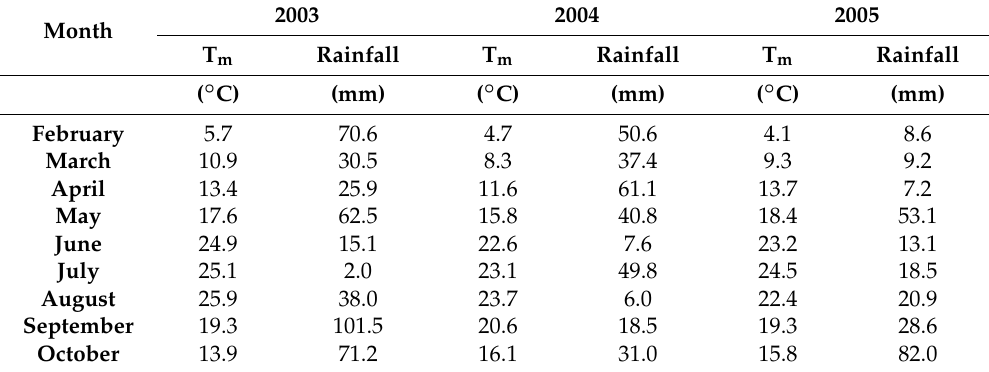
Table 1. Mean monthly (T m ) air temperatures and total monthly rainfall at Gimenells, during the experiment (from 2003 to 2005). Long-term (30 year) mean annual temperature and rainfall values at Gimenells are 14.6 ◦ C and 345 mm,